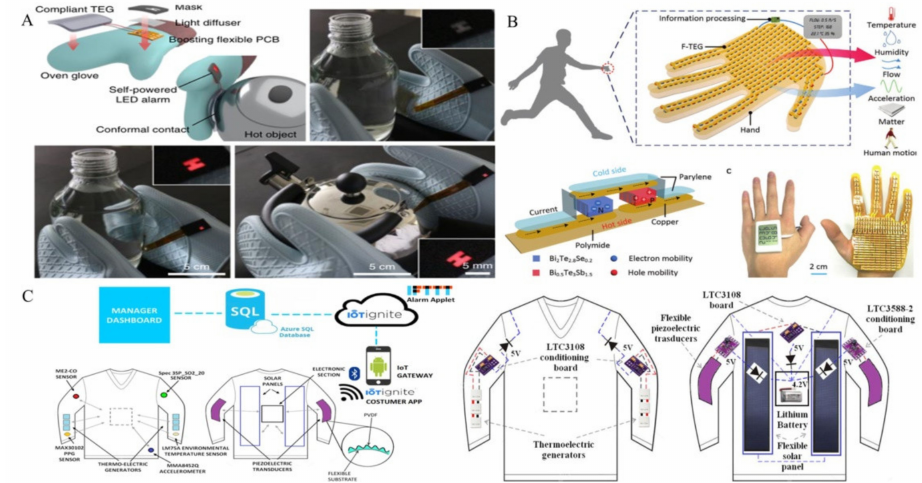
Figure 14. ( A ) Temperature detection device based on s-FTEG [76]. ( B ) A multifunctional detection system based on a palm-type thermoelectric generator [119]. ( C ) Intelligent clothing system